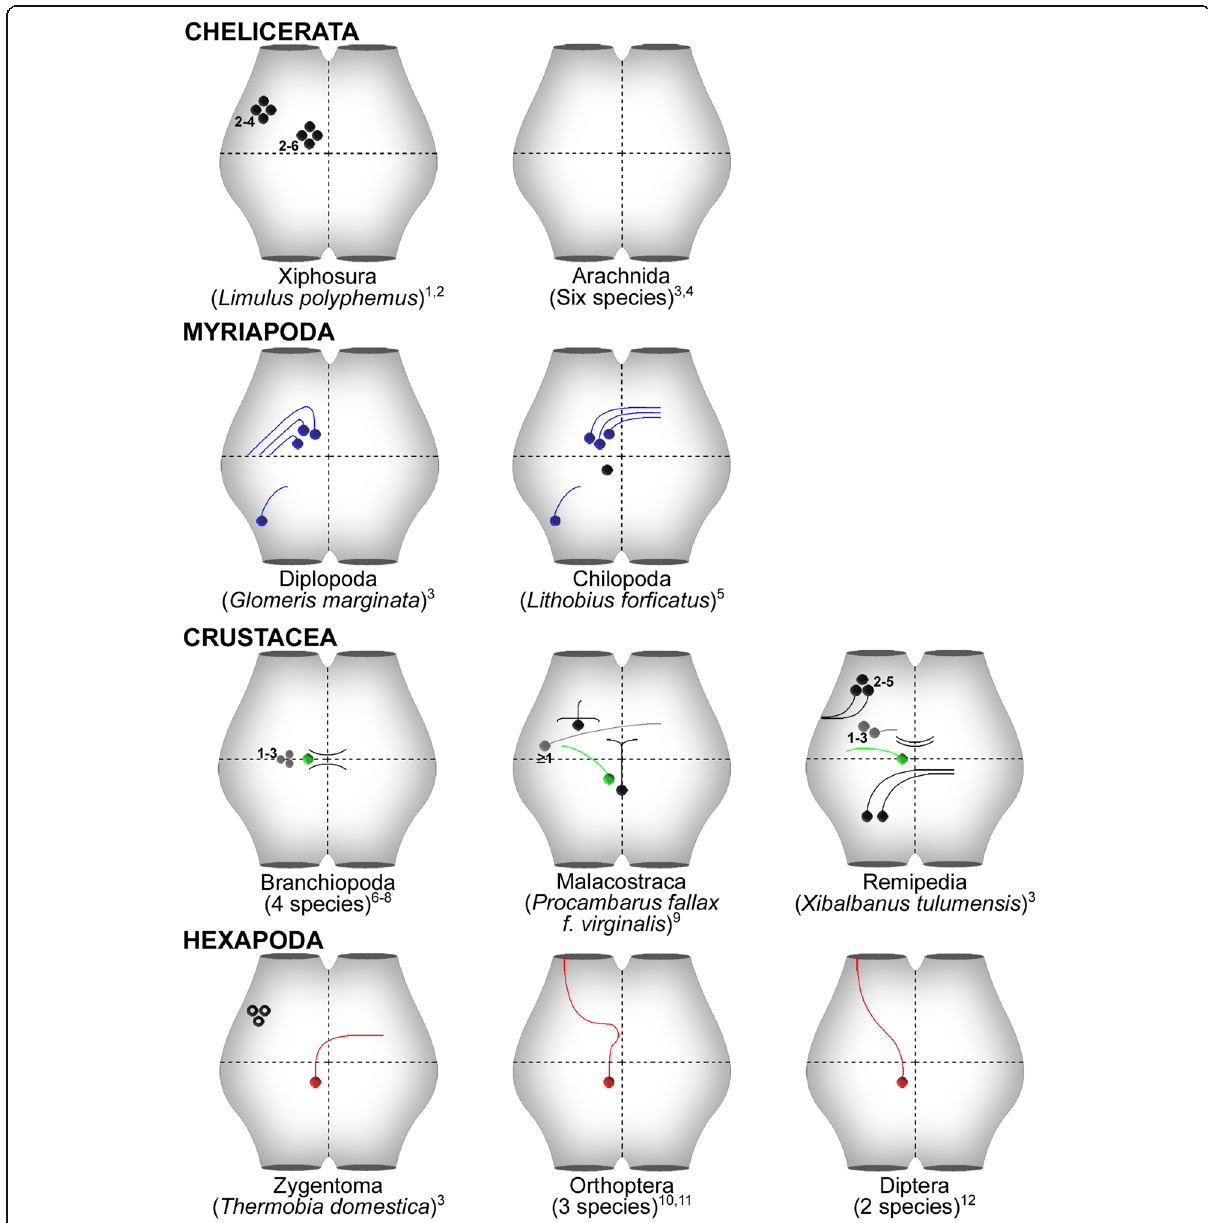
Fig. 9 Patterns of histaminergic neurons in the ventral ganglia for the major euarthropod taxa. Blue, green, and red neurons are interpreted as homologous neurons within the respective taxa. Gray neurons in the crustacean taxa might be homologous, but this has to be proven in future studies. Black neurons do not have corresponding cells in other taxa. Numbers near cell groups depict the variability in cell number of the respective group. Open circles in the zygentoman pattern show neurons that are only found in the thoracic ganglia. Patterns are based on the original descriptions from 1: [42]; 2: [43]; 3: this study; 4: [45]; 5: [41]; 6: [47]; 7: [48]; 8: [49]; 9: [51]; 10: [52]; 11: [53]; 12: